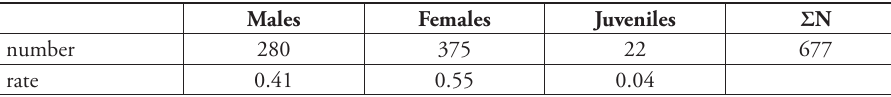
Table 1. Distribution of pit-fall trapped individuals by gender and